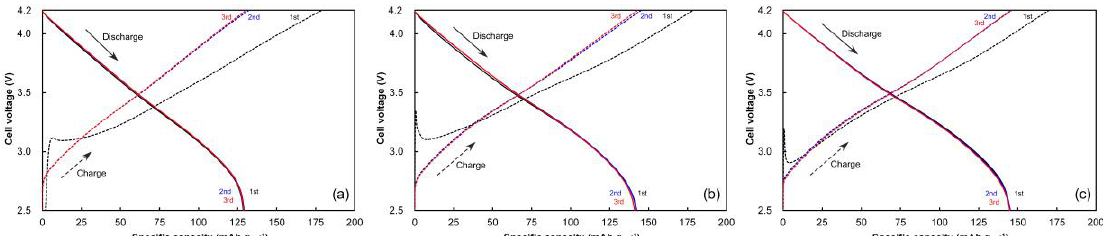
7 of 15 Figure 4. The open circuit voltage (OCV) of the half-cells and full-cells just after cell assembly. 3.4. Pre-Cycling for Cell Formation Figure 5 shows the charge-discharge behaviors of full-cells with pristine and prelithiated HC NEs in pre-cycling tests under a low current density (0.1 C-rate, 17 mA g PE−1 ). Pre-cycling was executed for cell formation, with the aim of achieving stable formation of SEI film on the NE surface. The CE of the pristine HC cell at the first charge-discharge cycle was 71.9%. The two full-cells with prelithiated HCs showed higher CE values (79.6% for the shallow prelithiation HC cell and 85.4% for the cycling prelithiation HC cell). In the first charging process, the pristine HC cell exhibited a modest increase in cell voltage within the specific capacity of 6.2 mAh g PE−1 . The precipitous increase of cell voltage for the prelithiated full-cells was observed at the initial charging stage (<1 mAh g PE−1 ). For the full-cells with prelithiated HC NEs, irreversible reactions chiefly resulting from the SEI formation on the NE side hardly occurred. Thus, the potential overshoots observed in the initial charging of the full-cells were caused by the first Li-ion extraction of the NCM PE. The charge and discharge specific capacities and the CE values in the first to third cycles are summarized in Table 2. Within the two charge-discharge cycles, the CE of the cycling prelithiation HC cell increased to 99.4%, which was the highest CE in all of the full-cells. At the second and third cycles, the pristine HC and the shallow prelithiation HC cells showed high CE values >97%. Prelithiation with the shallow Li-ion insertion was only effective for CE enhancement at the first charge-discharge cycle. Although all of the full- cells exhibited similar levels of first charge specific capacity, in the range of 176–179 mAh g PE−1 , the first discharge specific capacity of the full-cells was dependent on the prelithiation process. It was